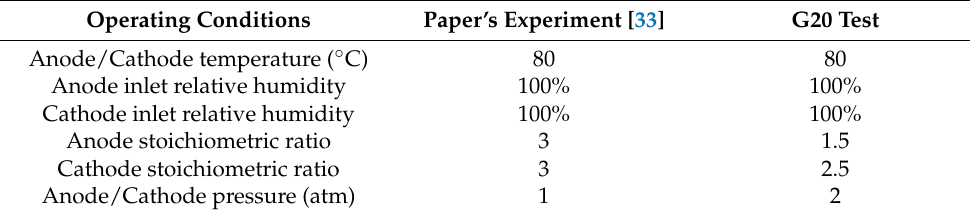
Figure 5. The photographs of the test bench: ( a ) G20 fuel cell test station; ( b ) PEMFC single cell. Table 1. Operating conditions in the experiments for comparison.